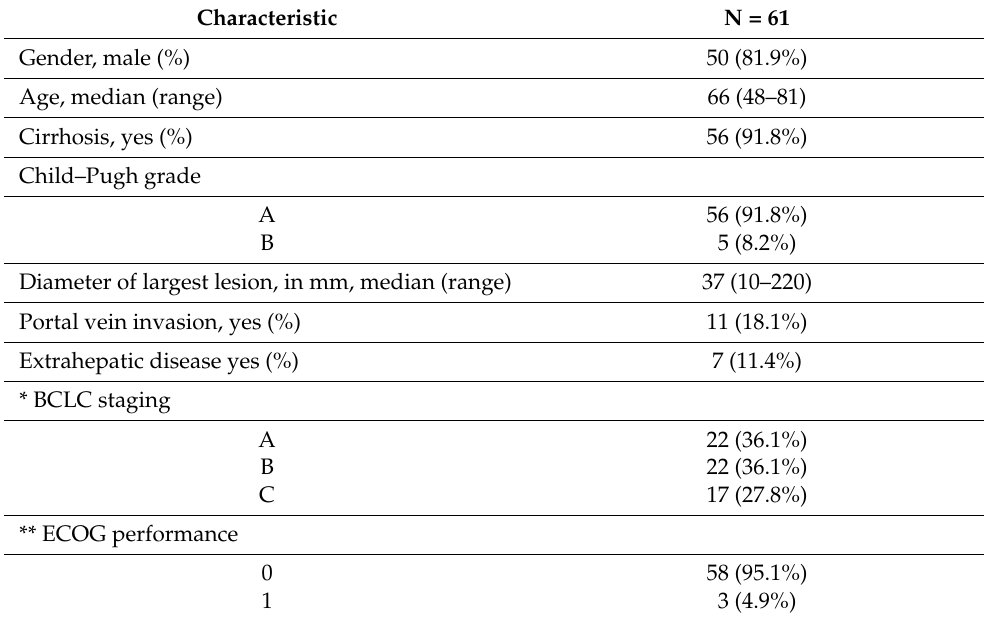
Table 2. Patient